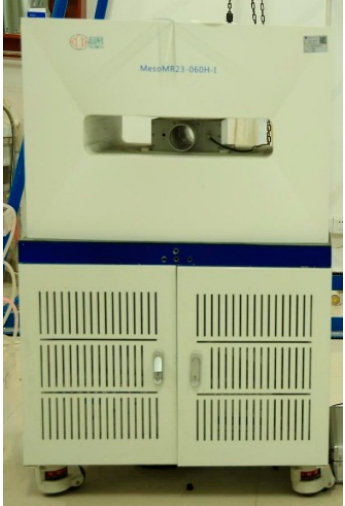
Figure 5. Experimental apparatus.